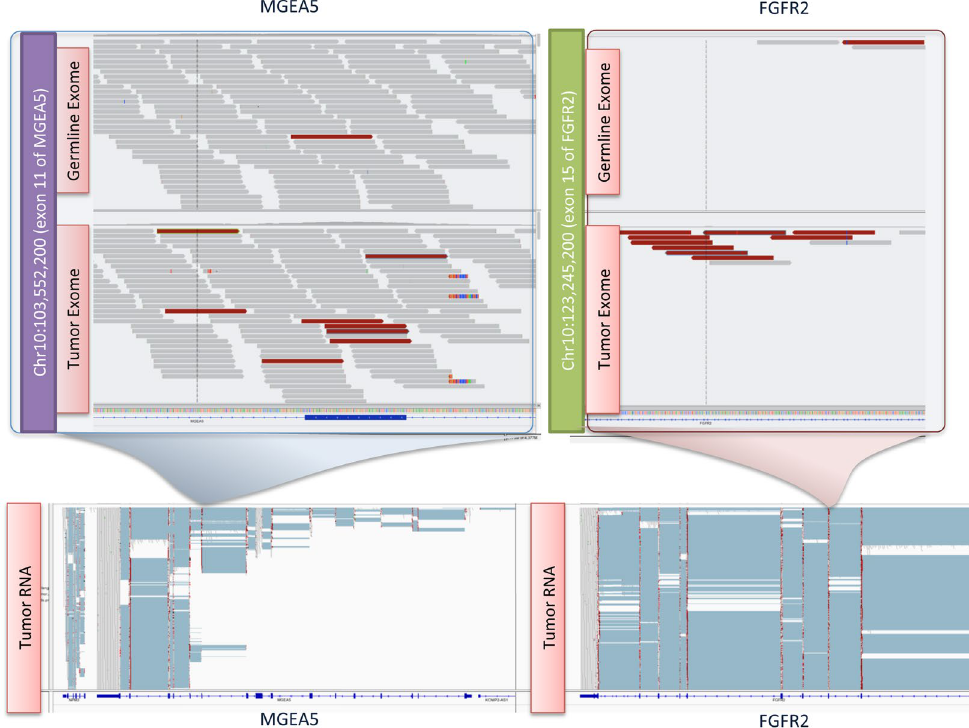
Figure 4. Visualisation of FGFR2-MGEA5 fusion in the Integrative Genomics Viewer